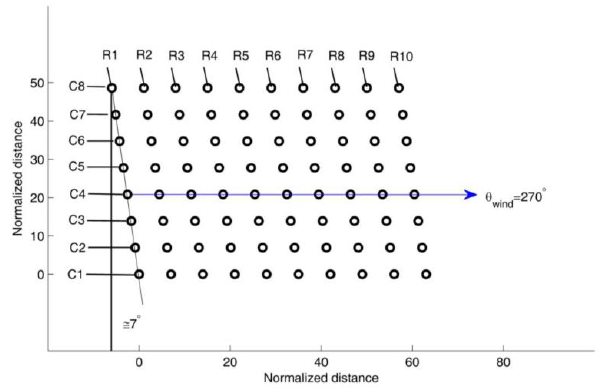
Figure 3. Layout of the Horns Rev wind farm. Distances are normalized by the rotor diameter 𝑑 = 80 .